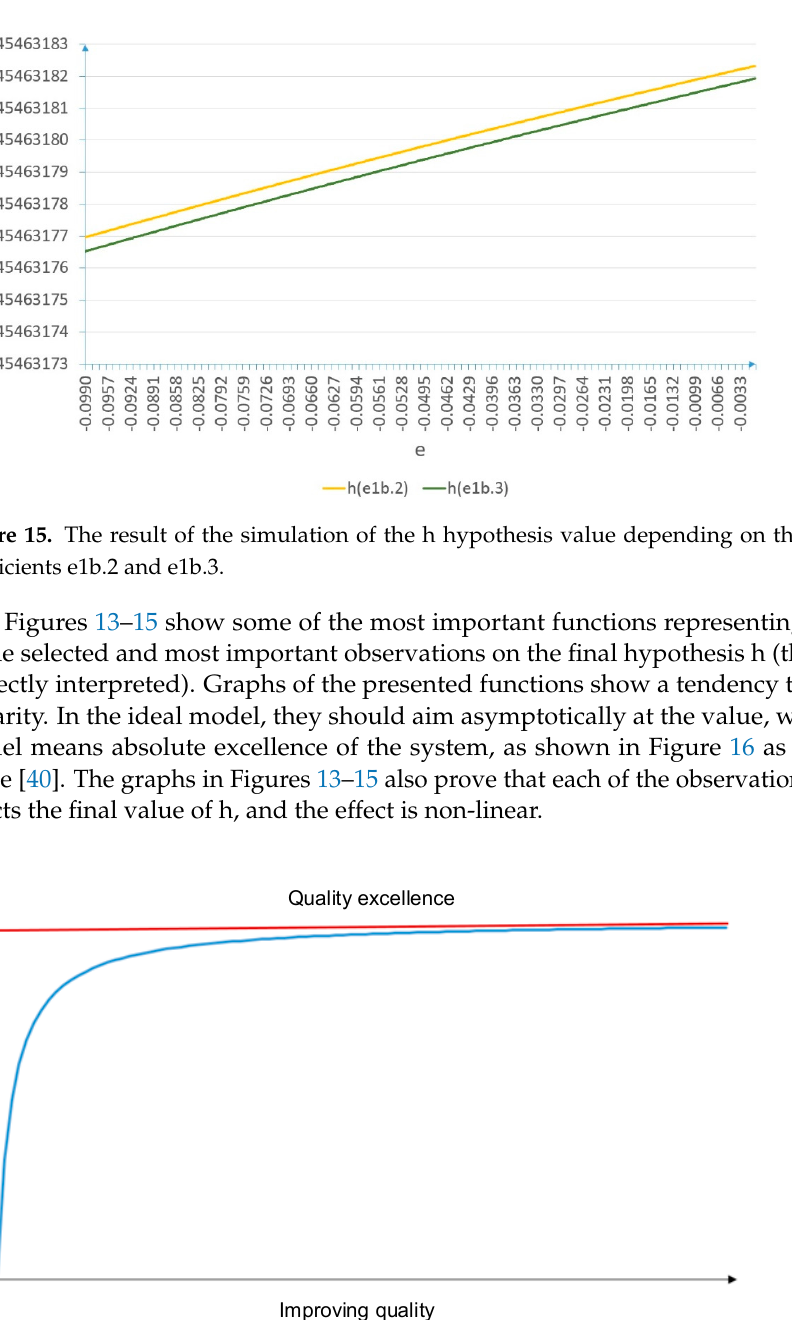
Figure 14. The result of the simulation of the h hypothesis value depending on the observation coefficients e1a.2 and e1a.3. The next graph (Figure 15) shows the influence of the negative coefficients of obser- vations related to the digital temperature sensor. The range of the coefficients e1b.2 and e1b.3 is from − 0.099 to − 0.001. The coefficient e1b.4 was omitted because function h (e1b.4) has the same values as function h (e1b.3).